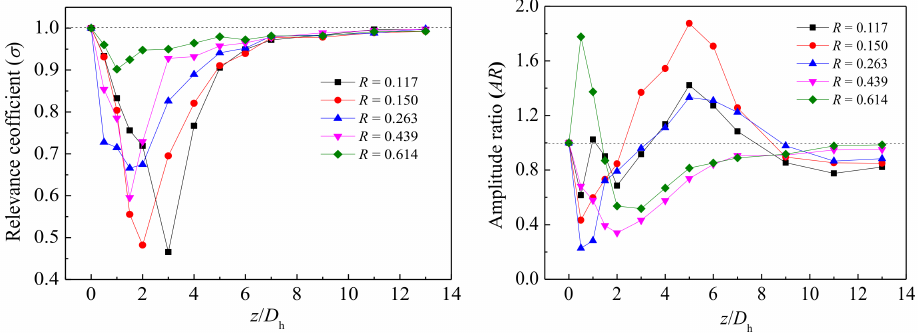
Figure 13. Relevance coefficients ( left ) and amplitude ratios ( right ) under different R without